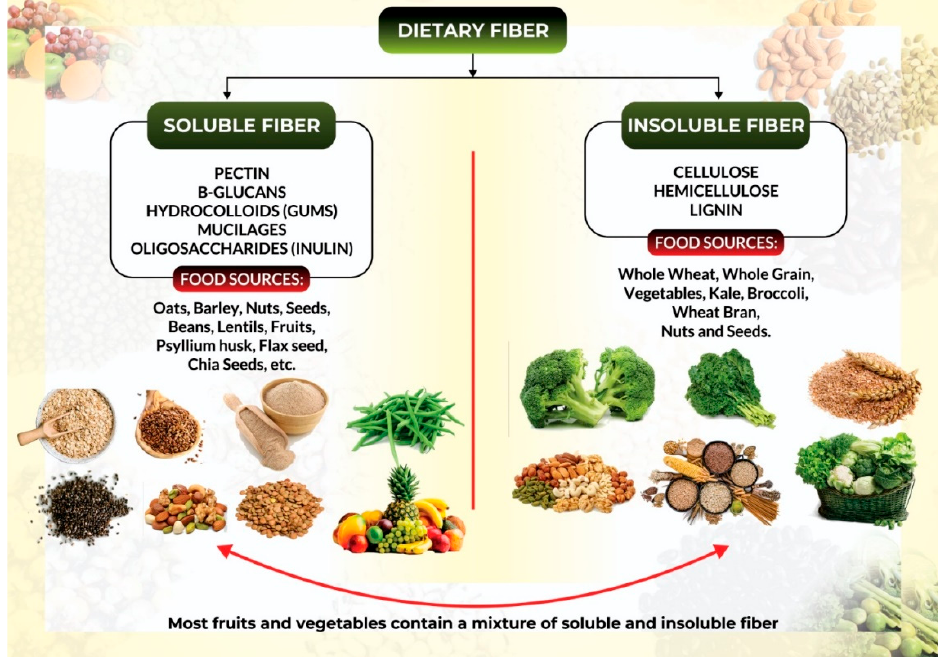
Figure 1. Classification of dietary fiber and its corresponding food